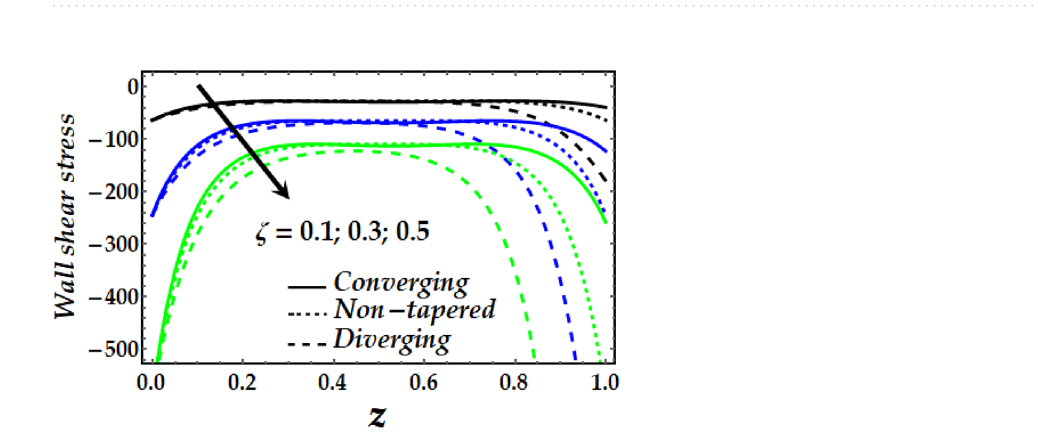
Figure 20. Wall shear stress against distinct values of ζ